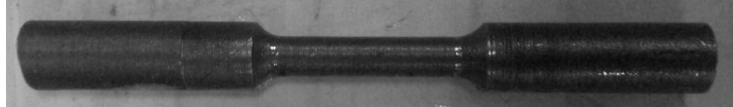
Figure 2. Cylindrical specimen for uniaxial test.